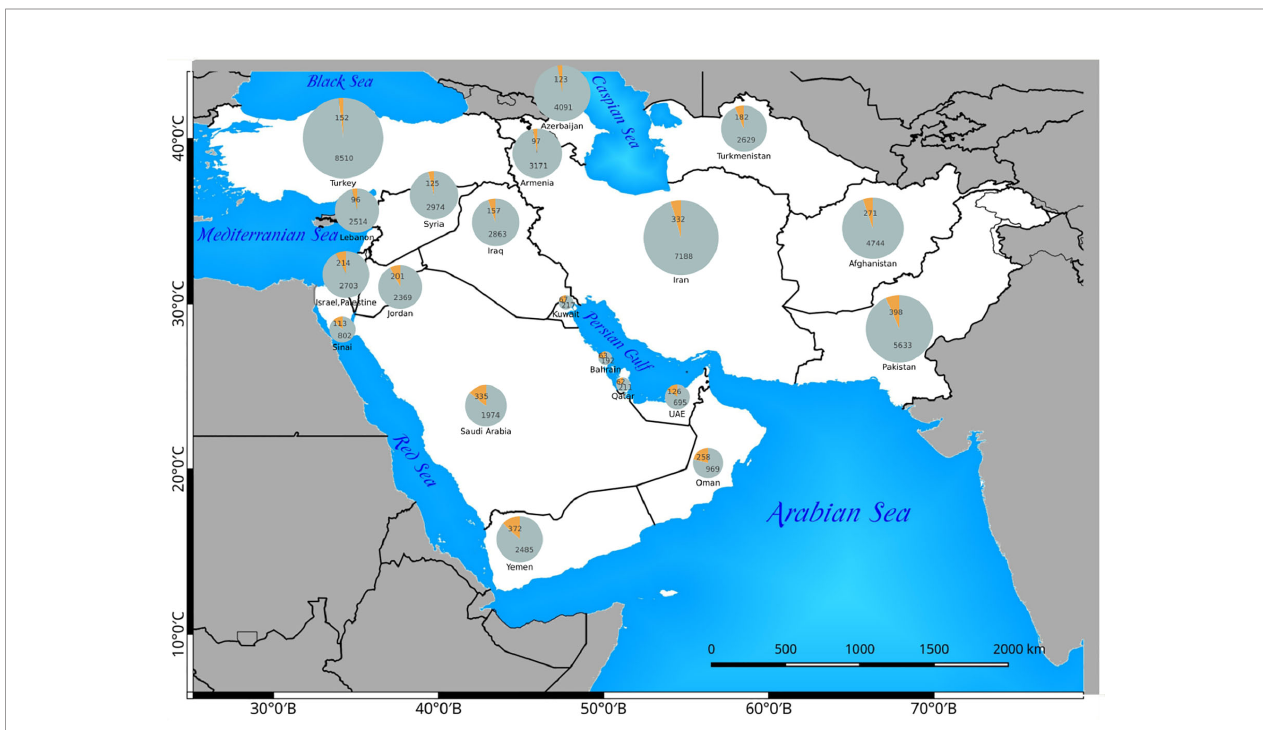
FIGURE 5 | The distribution of C 4 plants (orange) in relation to the total fl ora (gray) of any Southwest (SW) Asian country. The absolute number of C 4 and C 3 species are indicated in the related pie